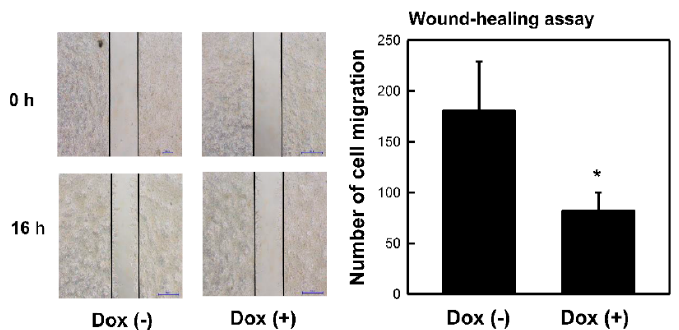
Figure 2. Effects of MCPIP3 overexpression on cell migration of T-REx 293/HA-MCPIP3 cells. Cells were treated with 1 μ g/mL of doxycycline (Dox) for 16 h, and the number of cells migrating was determined by a wound-healing assay (magnification ×200). A representative photo and quantified data are shown. Each value represents the mean ± SE from three independent experiments. * p < 0.05 vs. doxycycline-free cells.